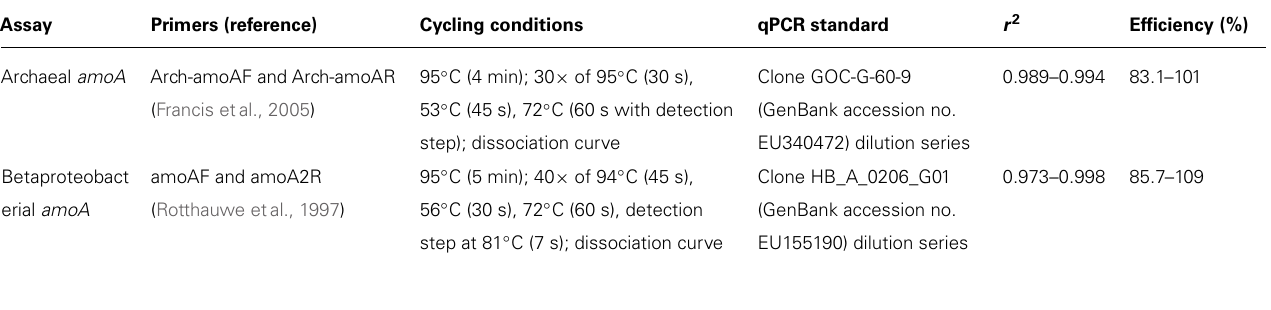
Table 1 | Primers (and relevant references for primer sequences) cycling conditions used for qPCR, qPCR standards and standard curve correlation coefficients, and qPCR efficiencies. Assay Primers